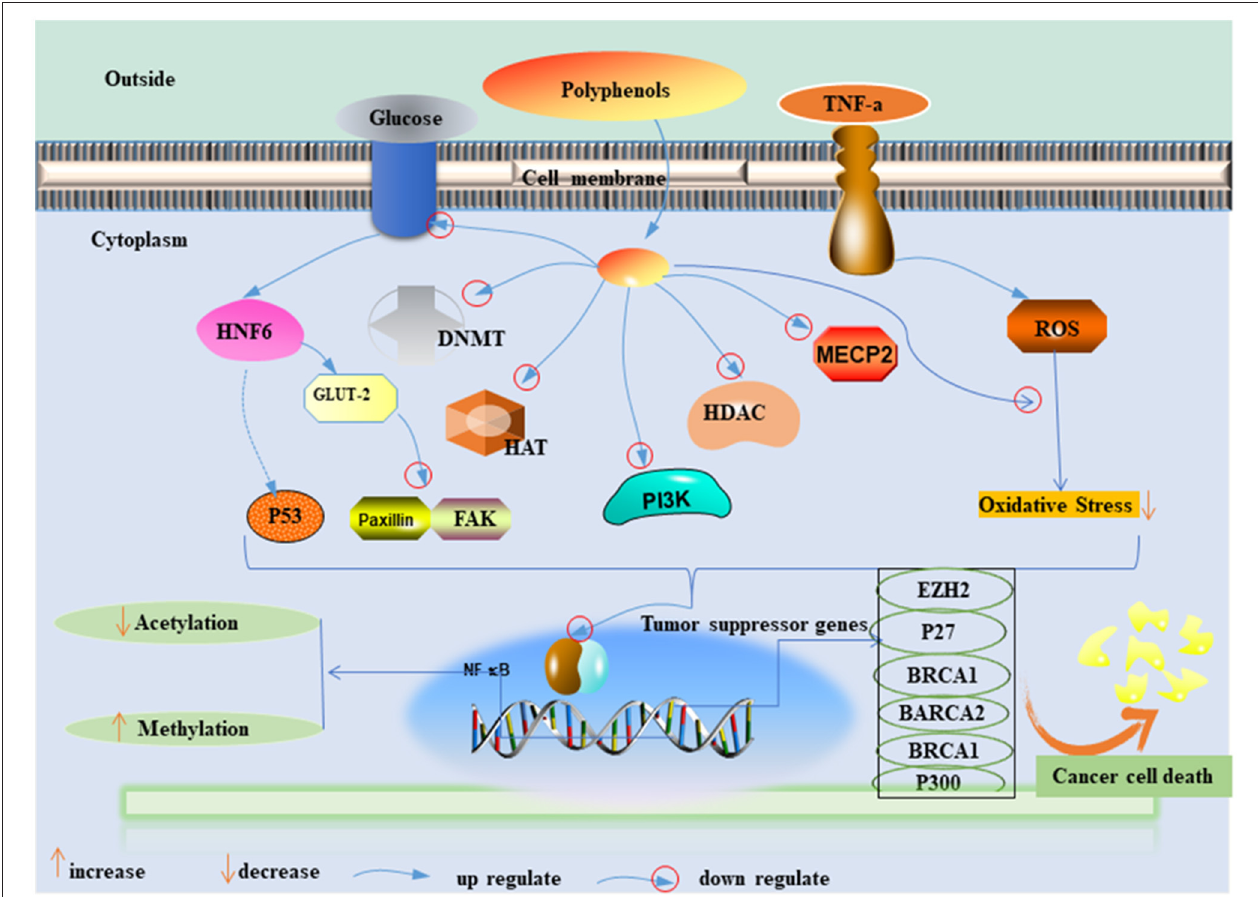
FIGURE 1 | Possible mechanisms of polyphenol effect on the inhibition of BC cell proliferation. PI3K, phosphoinositide-3–kinase; TNF a, tumor necrosis alpha; ROS, radioactive oxide species; NF- κ B, nuclear factor kappa light chain enhancer of activated B cells; DNMT, DNA methyltransferase; HAT, histone acetyltransferases; HMT, histone methyltransferases; HDAC, histone deacetylases; GLUT-2, glucose transporter-2; MeCP, methyl CpG binding protein; EZH2, enhancer of zeste homolog 2; BRCA1, 2, breast cancer 1, 2; HNF- 6, hepatocyte nuclear factor 6; FAK and paxillin, two focal adhesion–associated